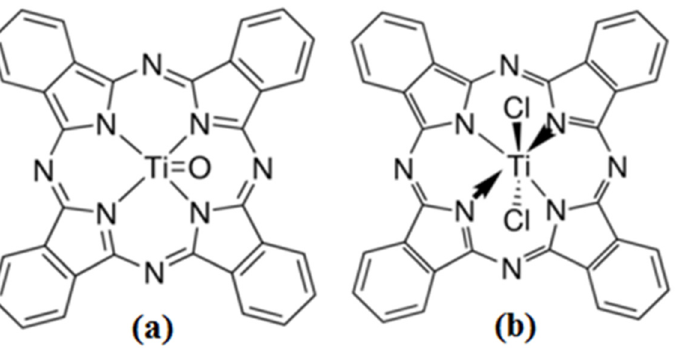
Figure 1. ( a ) Titanyl phthalocyanine (TiOPc) and ( b ) titanium (IV) phthalocyanine dichloride (TiCl 2 Pc).